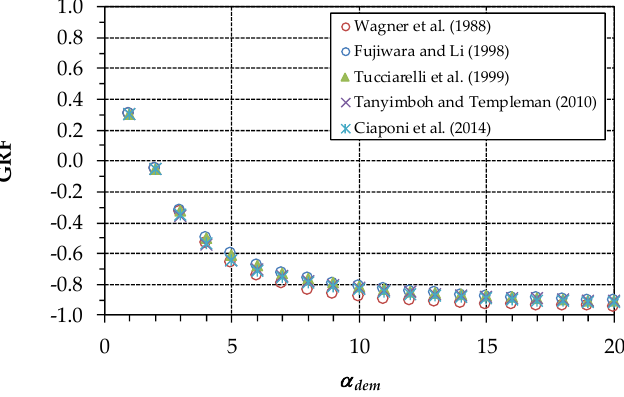
Figure 12. Second case study. GRF for the various formulations as a function of α dem .